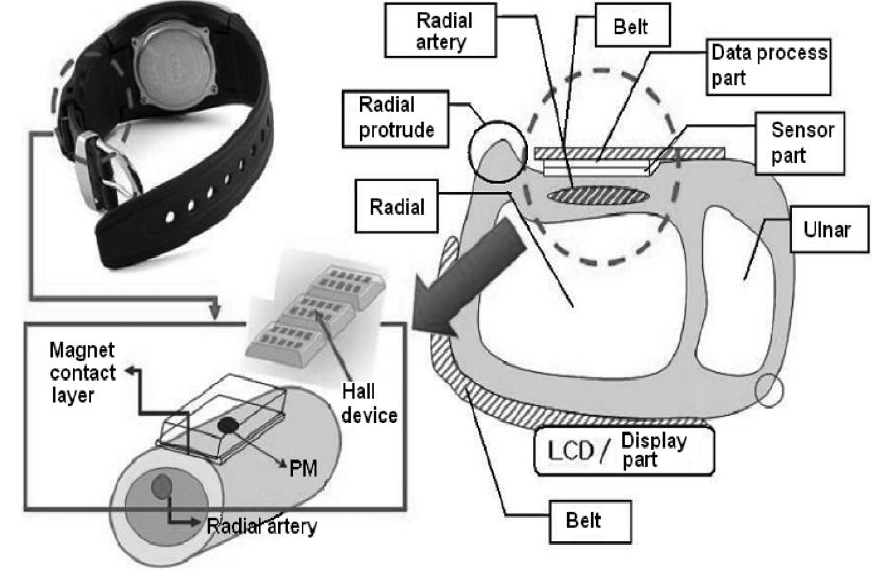
Figure 1. Diagram showing the basic structure of the wrist wearable radial arterial pulsimeter. Schematic cross-section of one form of the pulse-sensing and skin-contacting components of the arterial pulsimeter using multiple Hall devices and permanent magnets, respectively. The pressure chamber between the skin-contacting and pulse-sensing components is filled with